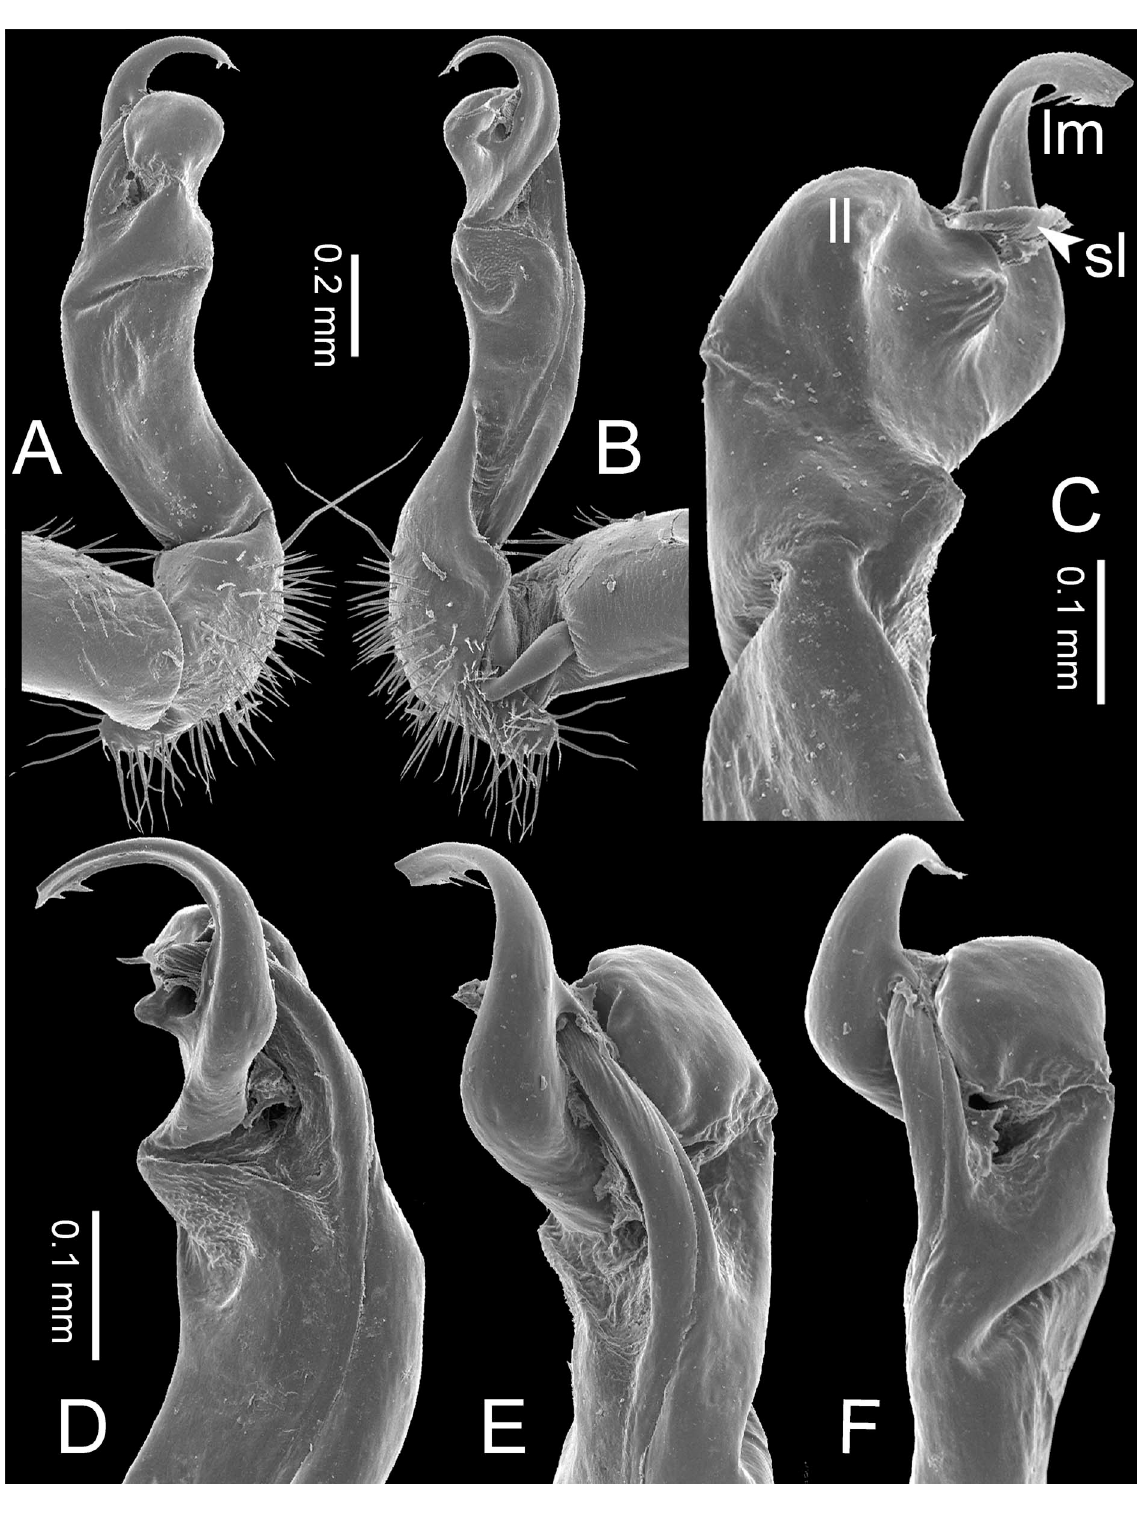
Fig. 10. Nagaxytes acantherpestes (Golovatch & Enghoff, 1994) gen. et comb. nov., specimen from Ban Yan Sue (Thailand), right gonopod. A . Lateral view. B . Mesal view. C . Ventral view. D , F . Subdorsal view. E . Dorsal